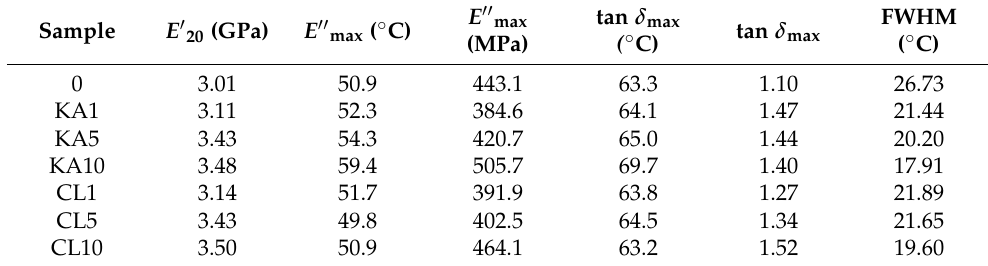
Table 3. DMA results of the prepared